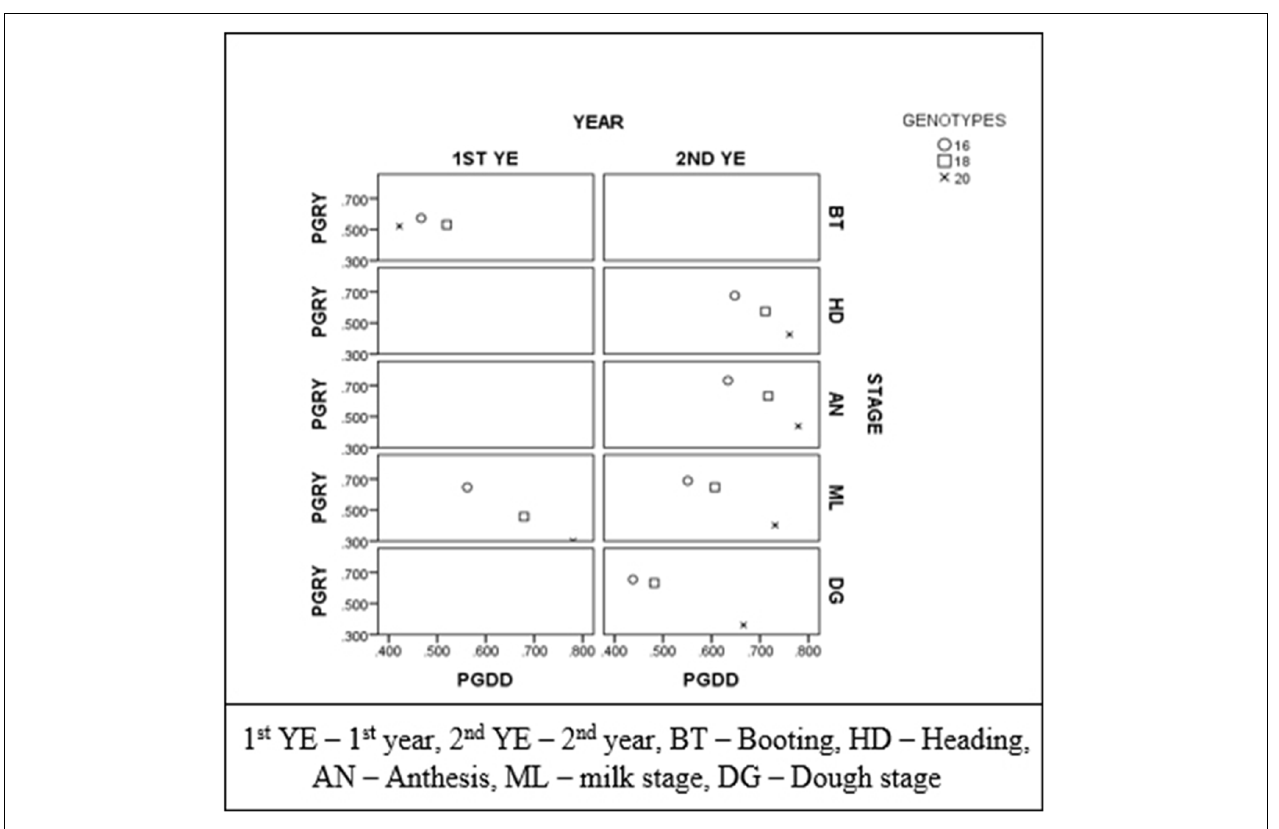
FIGURE 3 | Correlation coefficients between growing degree days to heading with NDVI (PGDD) plotted against coefficients between grain yield and NDVI (PGRY) for each year and recording stage. Each point represents the correlations when all genotypes were taken into account ( n = 20), when the two late heading genotypes were excluded ( n = 18) and when the four late heading genotypes were excluded ( n =